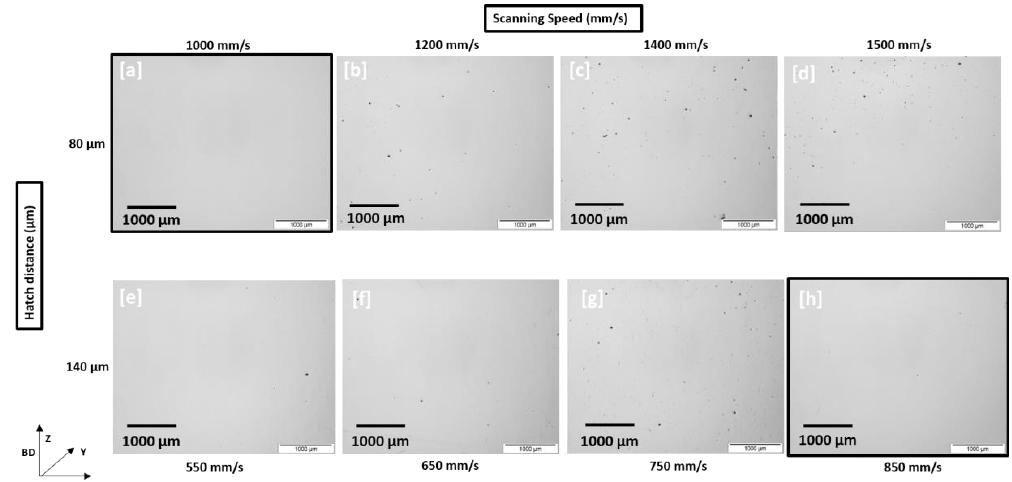
Figure 2. Light optical microscope (LOM) micrographs showing two different hatch distances with scanning speed variation at constant laser power (200 W) and layer thickness (30 µm) for unetched as-built cubes; the highest relative density of 99.8% was recorded at 1000 mm/s and 850 mm/s. Table 2. Process parameters and the respective relative densities of the as-built cubes shown in Figure 2.